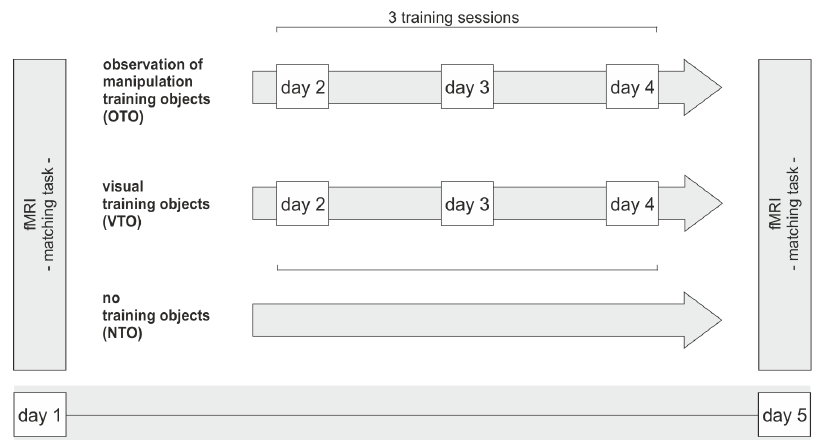
Figure 1. Experimental procedure.